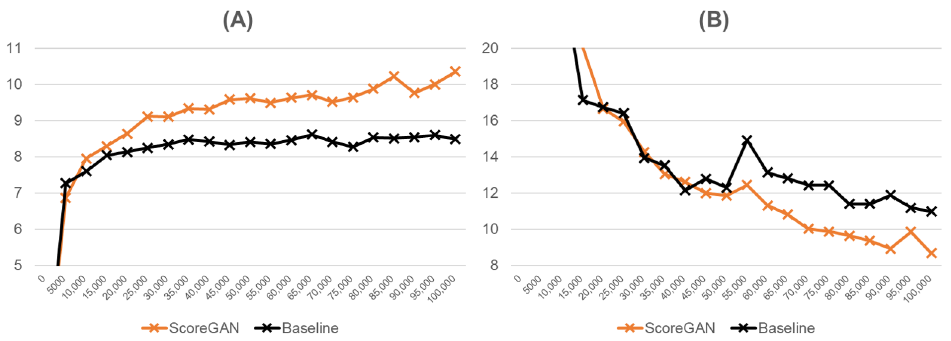
Figure 3. The performance of ScoreGAN in terms of the Inception score and Fréchet Inception distance over iterations. ( A ) The Inception scores; ( B ) the Fréchet Inception distance (FID). The baseline is ControlGAN with the same neural network architecture, identical to that of